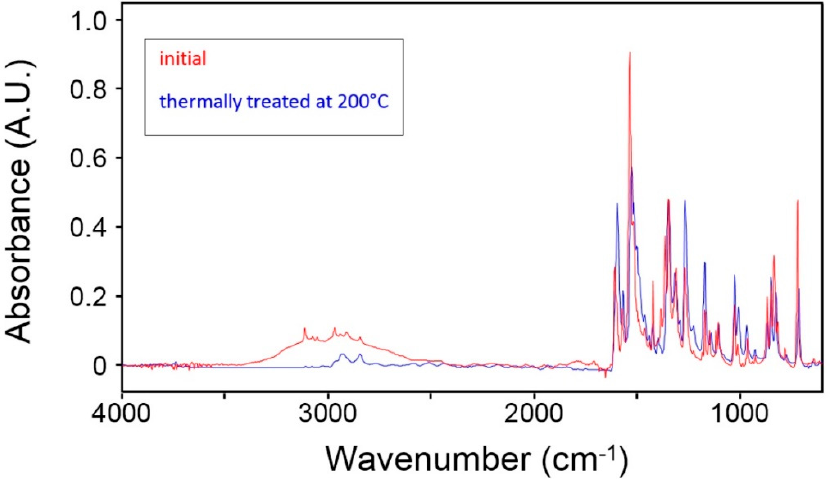
Figure 7. FTIR spectra of the as-prepared sample (red trace) and of the same after exposure to 200 °C under vacuum (10 − 2 Torr). Spectra collected at 30 °C.